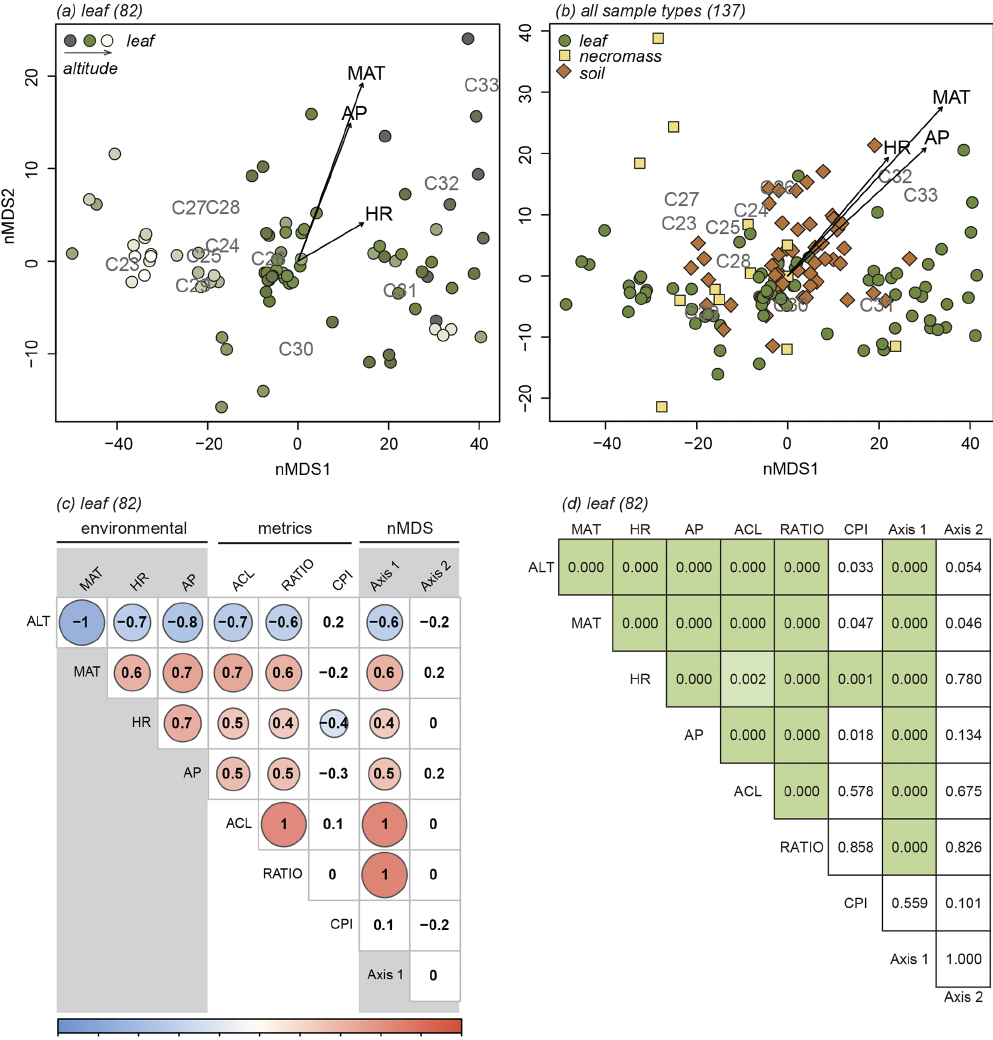
Figure C1. nMDS (a, b) and correlation results (c, d) of the leaf samples without the Miconia bracteolata species samples (four samples in